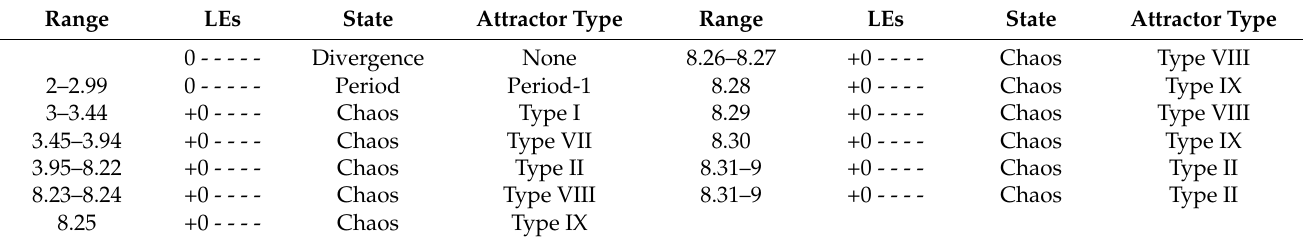
Figure 3. ( a ) Lyapunov exponent spectrum; ( b ) bifurcation diagram. Table 1. Corresponding state and LEs with the initial conditions (1, 1, 1, 1, 1), the parameters b = 2, c = 10, d = 21, k = 3, e = 10, g = 1.15 and the different parameter a .